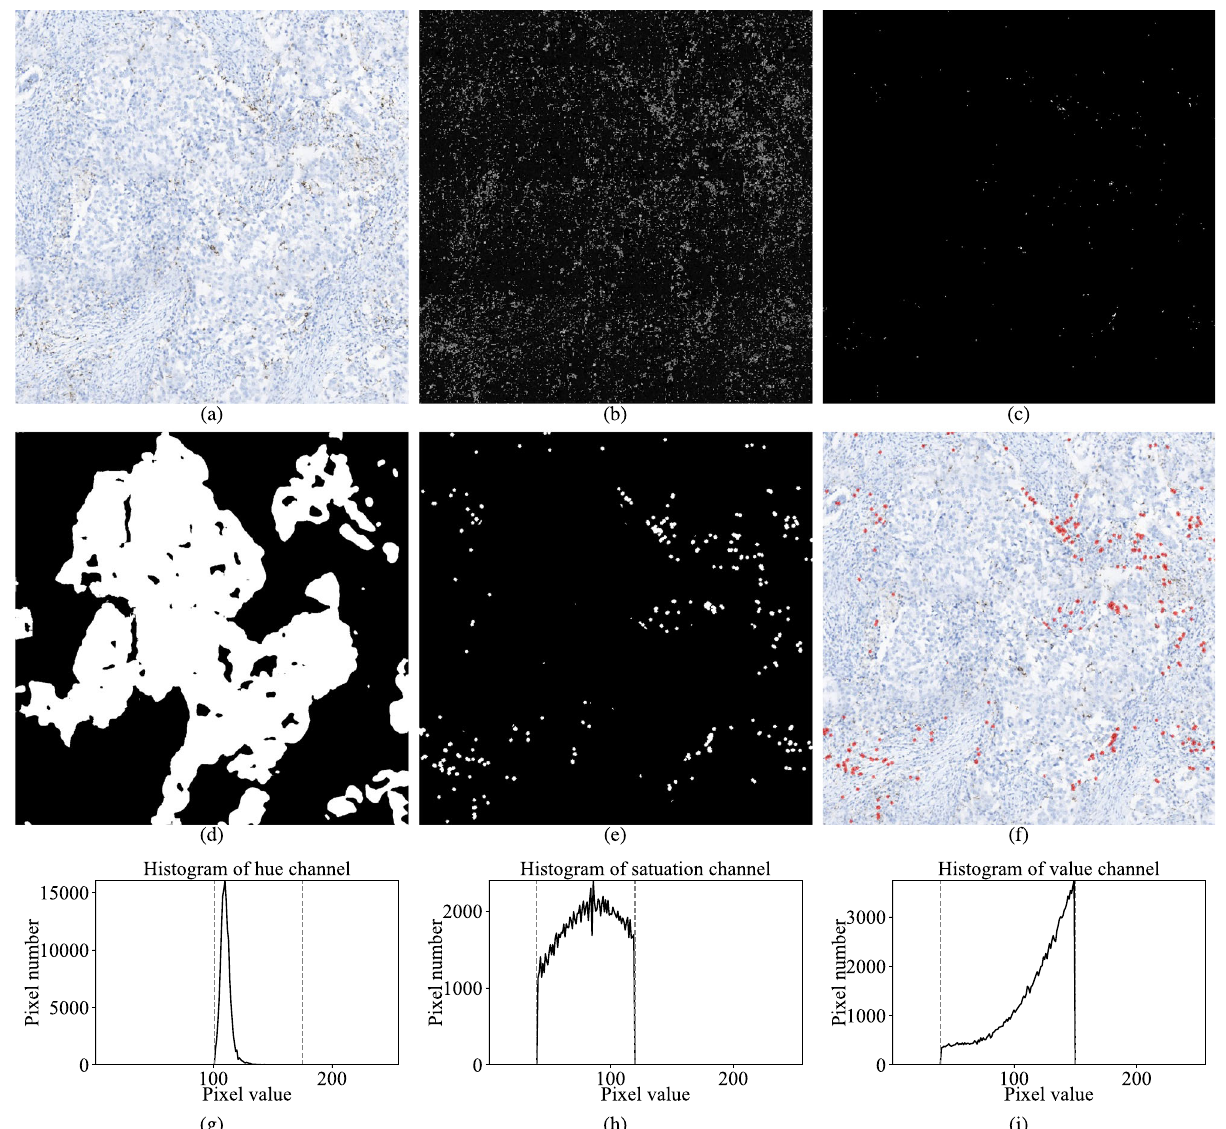
Fig. 2 Visual results of our AI-assisted PD-L1 scoring model. a Input image of X20 magni fi cation. b Hue channel of the transformed image. c PD-L1 stained cells mask M stain , including the stained cells inside the epithelial and necrotic regions. d Epithelium mask M epithelium . e IC mask M IC , which is the result after excluding stained cells inside the epithelial and necrotic regions and then image morphology processing on M stain . f Input image overlaid with IC mask M IC . Predicted IC score = 1.7 %. g – i The histograms of HSV image channels for stained PD-L1 (SP142) IC regions. Two gray dashed lines indicate the threshold on each